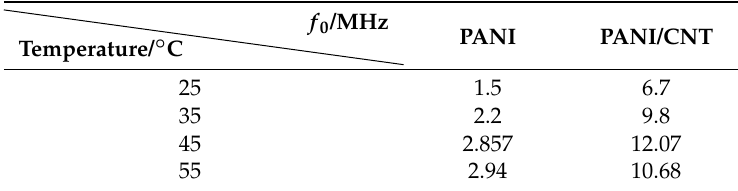
Table 2. Relationship between f 0 variation and temperature.